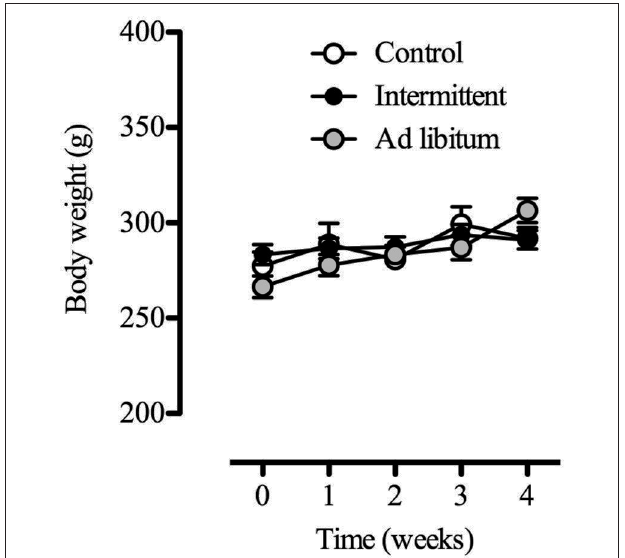
FIGURE 1 | Body weight (g) of animals differentially exposed to the sucrose solution (10%): no access (control, n = 14), 2-h daily access (intermittent, n = 16), and 24-h daily access ( ad libitum , n = 13) during the 28 days of the protocol. Data are expressed as means ±